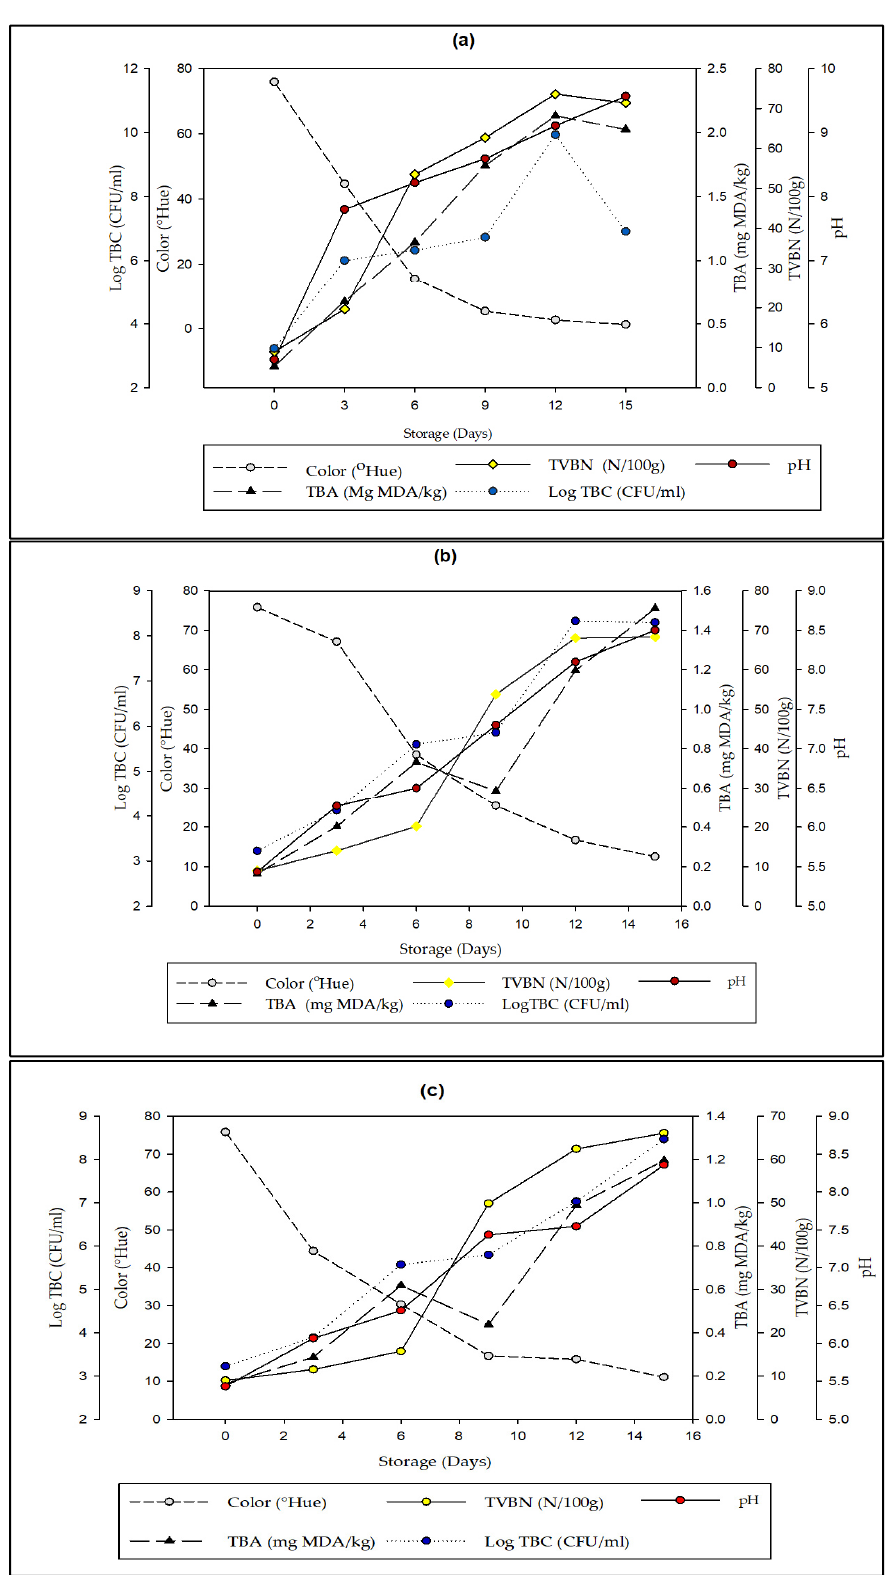
Figure 8. Correlation between indicator label sensor response with various parameters of quality deterioration in packaged fresh beef ( a ) 0%, ( b ) 15%, and ( c ) 20%. Based on Figure 8, beef stored without garlic extract (0%) experienced a rapid in- crease in the TVBN, TBC, TBA, and pH values compared to beef with garlic extract (15%